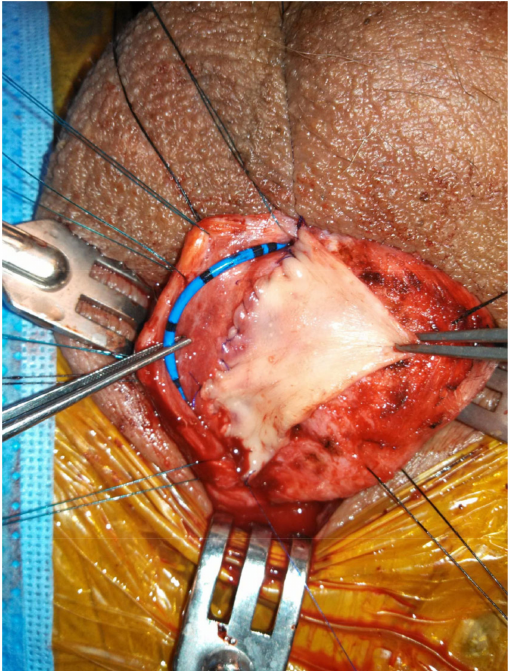
Figure 2. Non-transecting, dorsal onlay buccal mucosal graft urethroplasty.